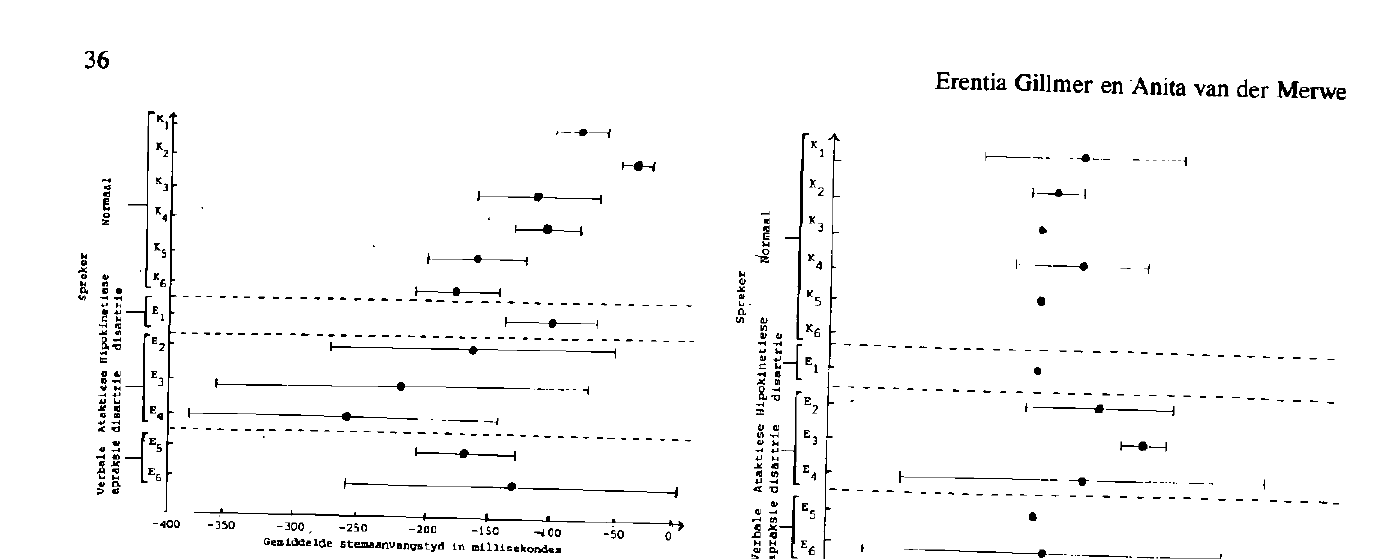
Figuur 3 Die gemiddelde SAT vir die klank /b/ met groot negatiewe waardes vir alle sprekers